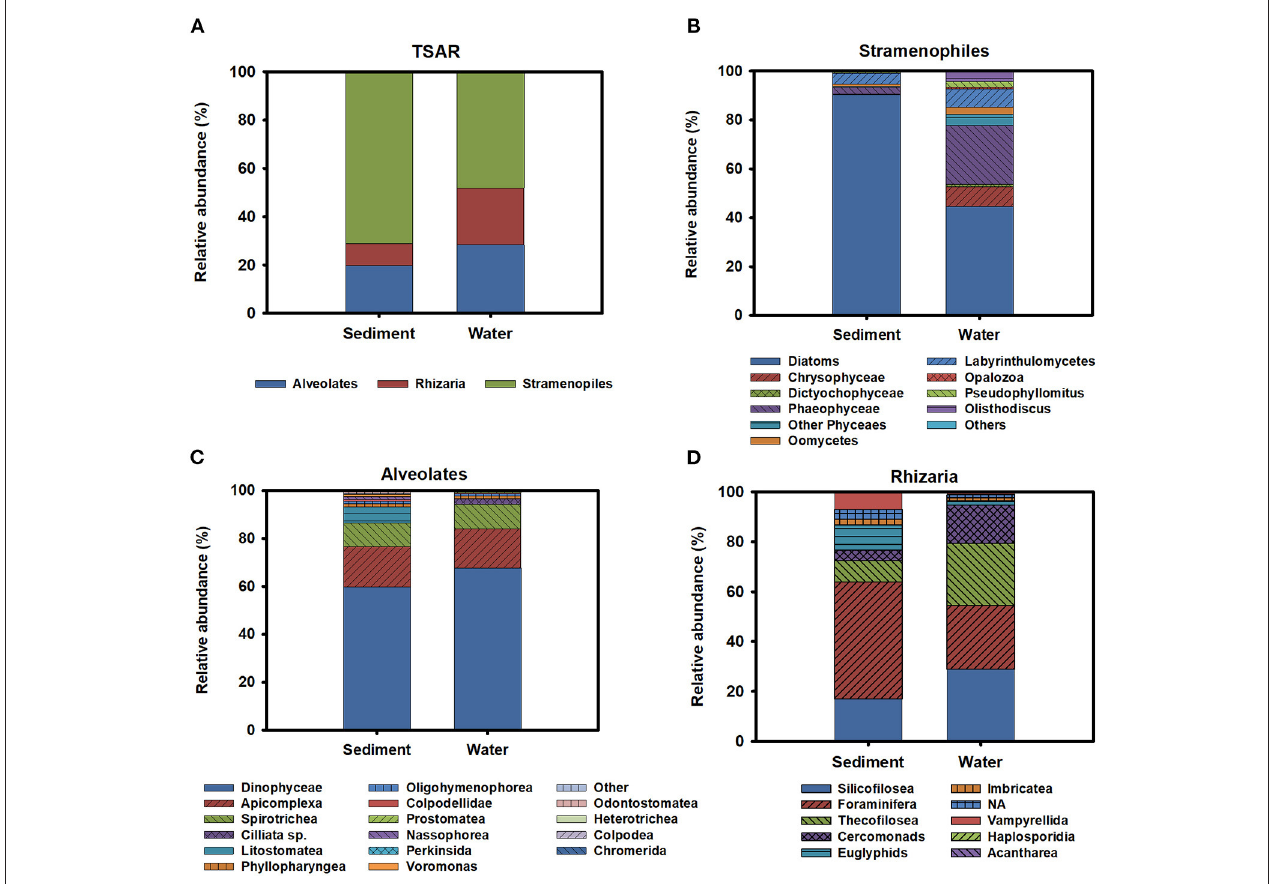
FIGURE 6 | (A) General description of the diversity observed inside the TSAR supergroup. Relative abundance of the different members of Stramenopiles (B) , Alveolates (C) , and rhizarians (D) in sediment and water.